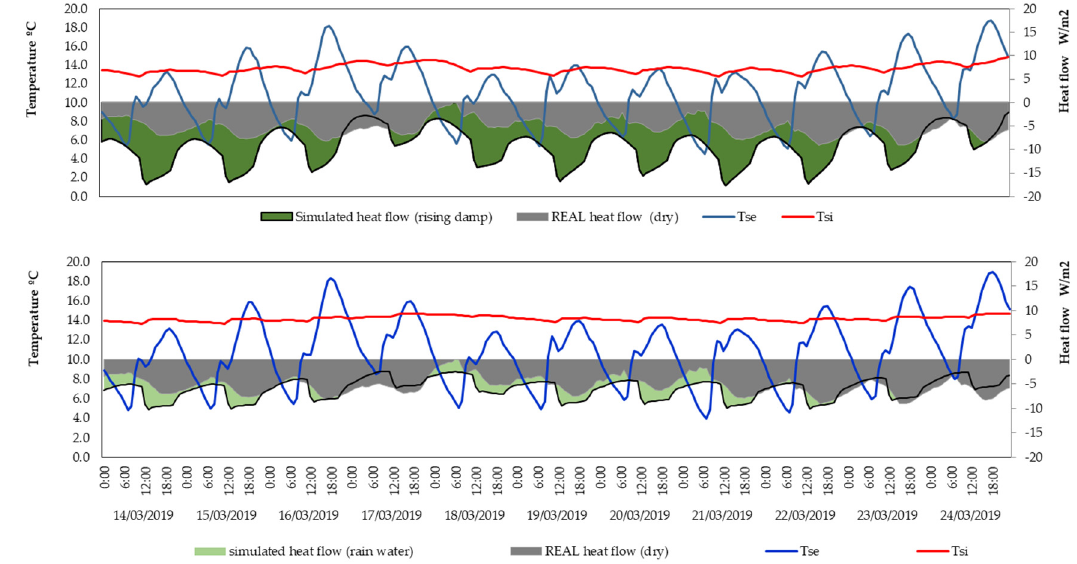
Figure 8. Top graph comparison between the thermal flow of the in situ test and the simulation in which the outer leaf is saturated with water. In the graphic above, the same type of comparison is made but in that case the wall is saturated with the water that ascends by capillary from the ground.